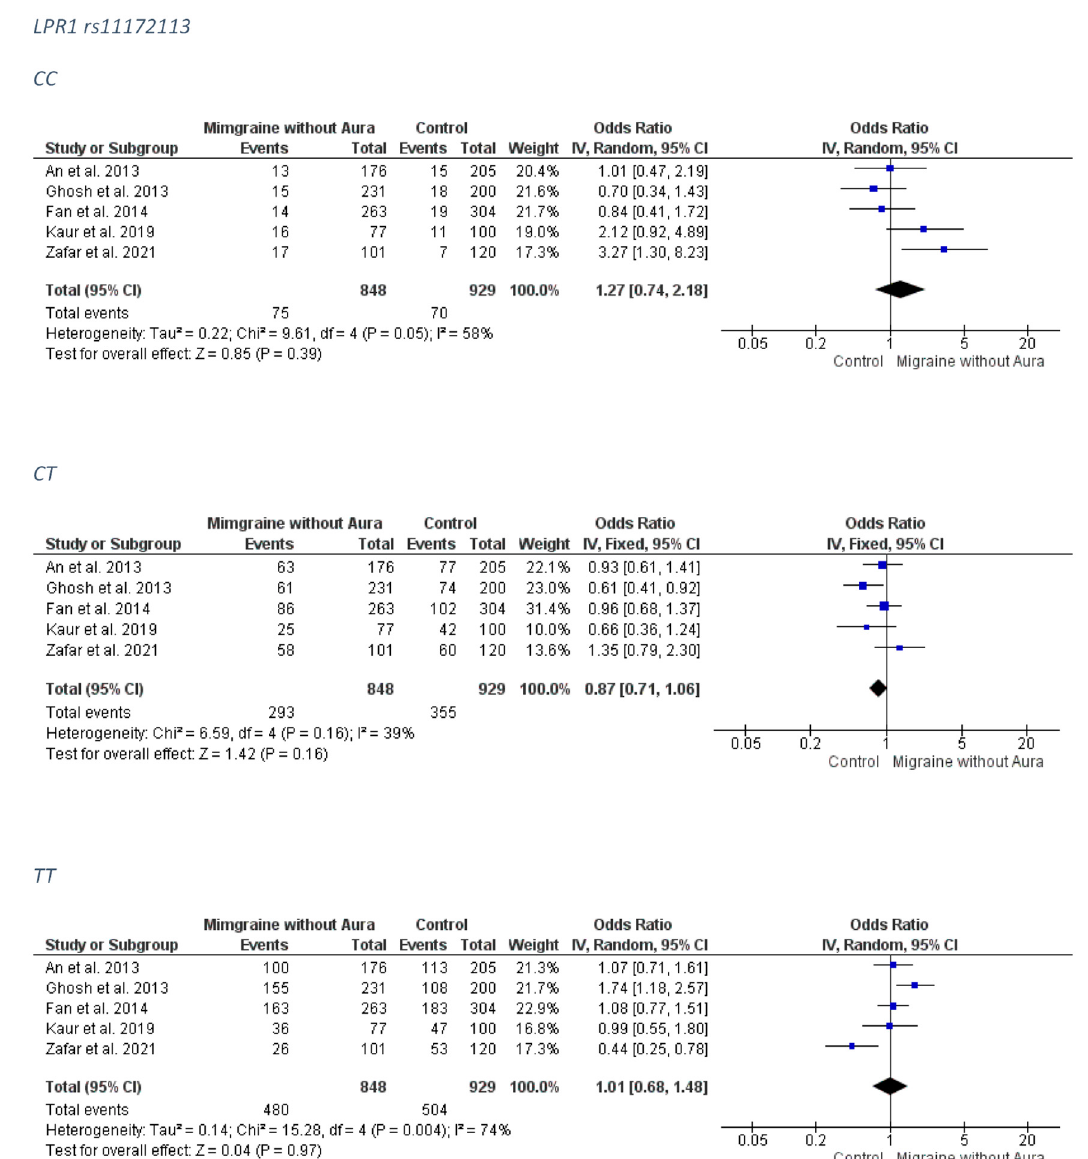
Figure 9. The forest plots presenting the results from meta-analysis of the rs11172113 and migraine without aura group .